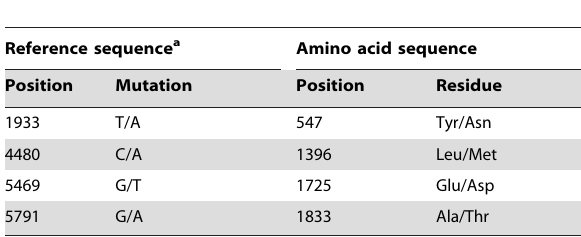
Table 2. Mutations found in the coding sequence of GBF1 in Huh-7